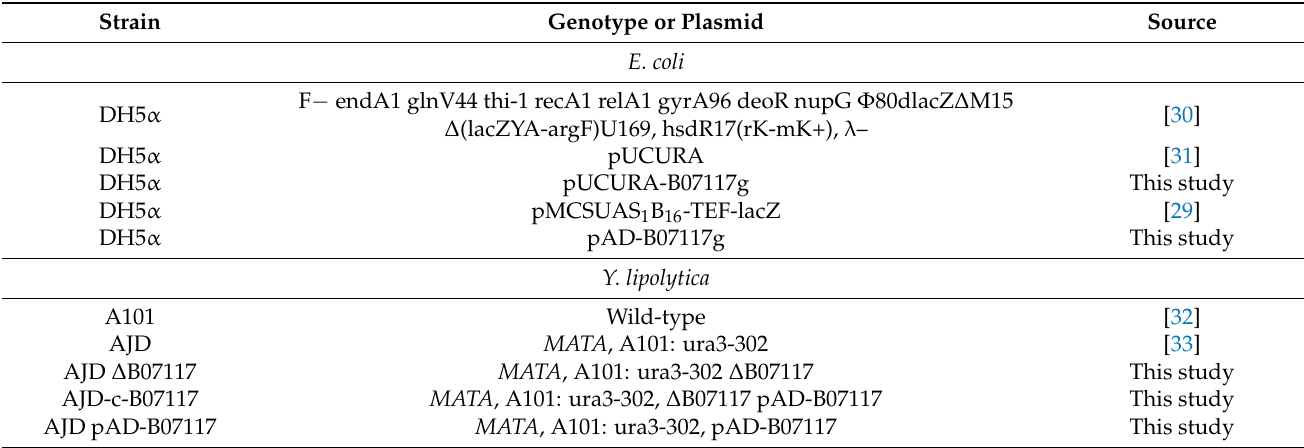
Table 3. Strains of E. coli and Y. lipolytica used in this